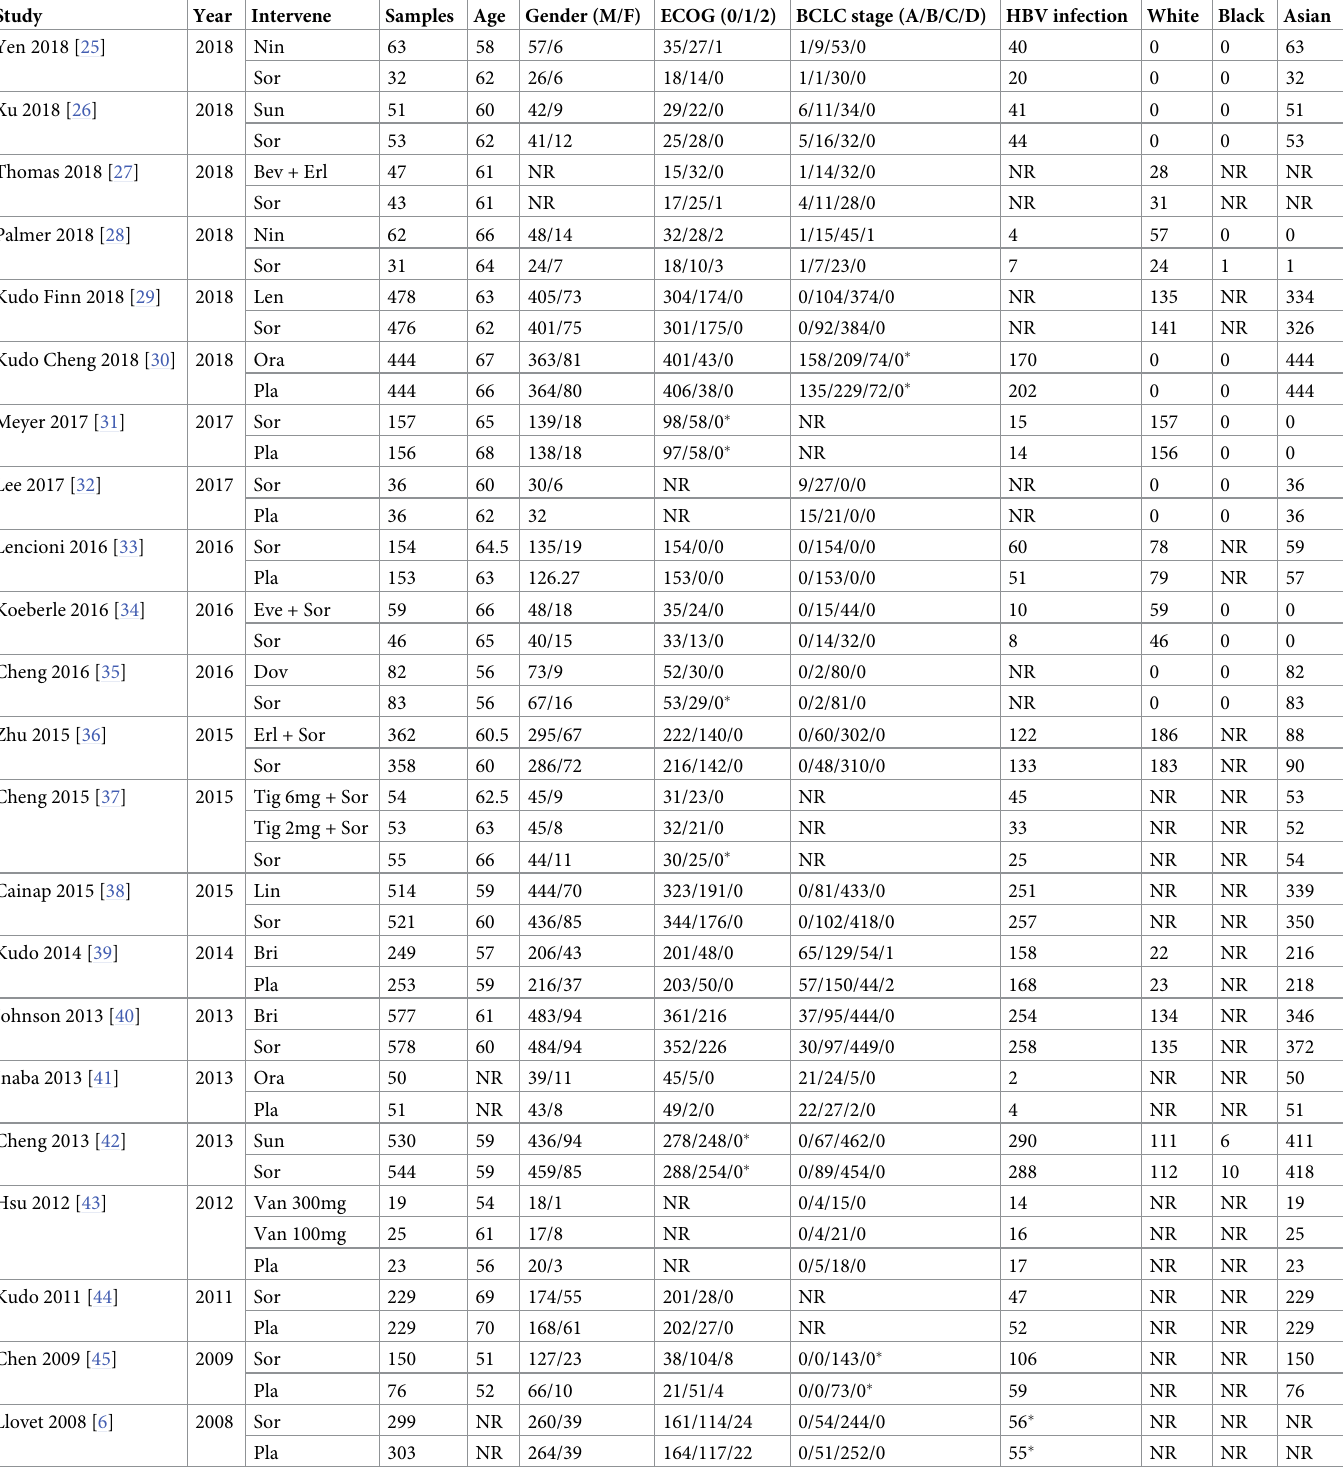
Table 1. Main characteristics of included